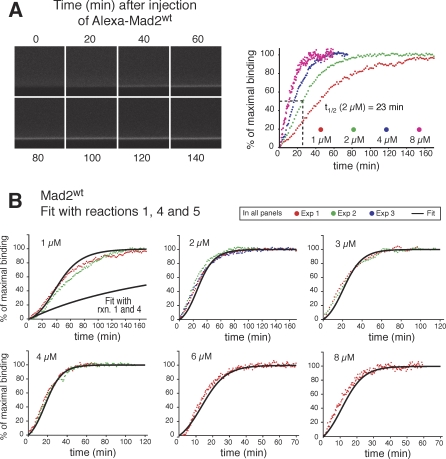
Kinetic Analysis for Rate Constants Determination of Mad2wt
(A) Different concentrations of Mad2wt were introduced in a flow chamber containing approximately 1 μM Cdc20.(B) Fitting of the binding curves of Mad2wt with reactions 1, 4, and 5 (Table S1 and Table S2) and parameters in Table I. The fitting was carried out contemporarily on all available curves and at different concentrations as described in Text S1. As for the goodness of the fit, see Text S1 and Figure S5. In the first panel (1 μM), a fit with only reactions 1 and 4 is also shown to demonstrate the importance of adding catalysis (reactions 5) in the fitting process. Notice how for low concentrations of Mad2, the kinetics follows a sigmoidal increase reflecting the slow initial binding of Mad2wt to Cdc20.